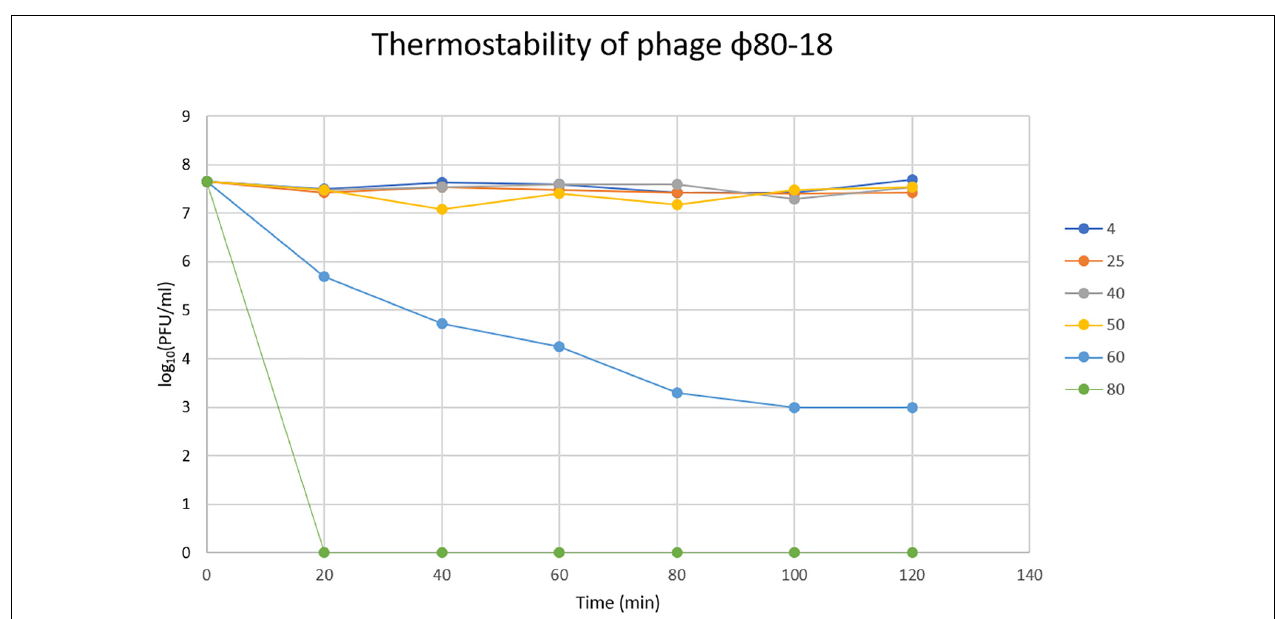
FIGURE 6 | Thermostability of bacteriophage φ 80-18 in temperature range 4–80 ◦ C.